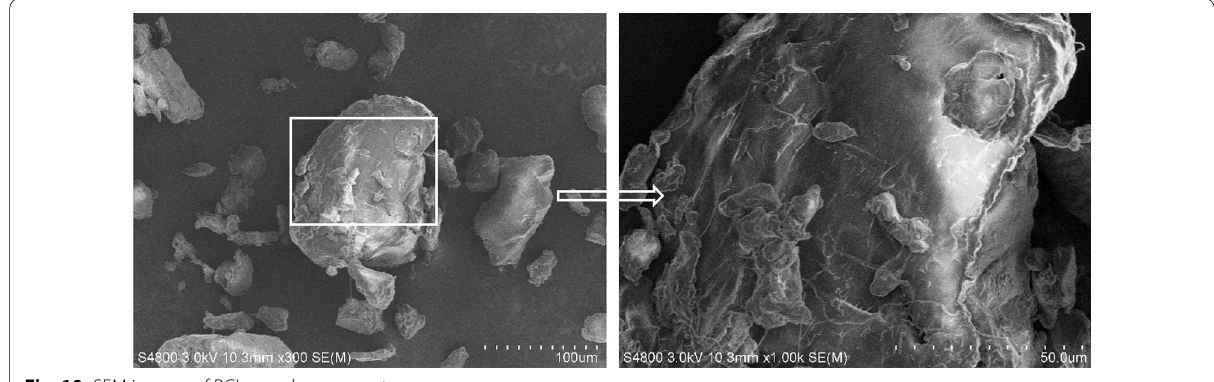
Fig. 10 SEM images of PCL powder aggregate.